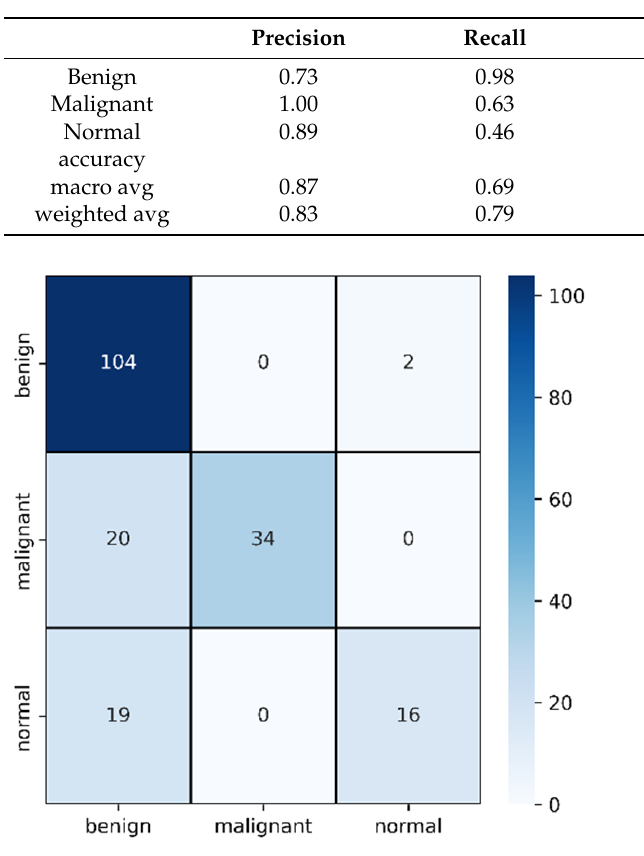
Figure 10. Confusion matrix for original image evaluation on 25% of test